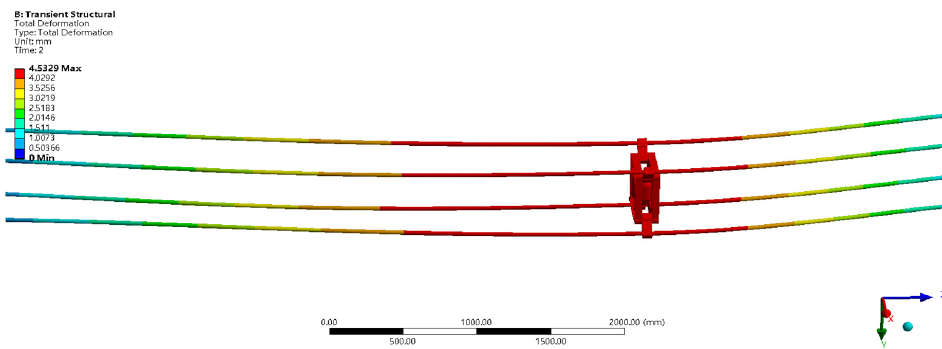
Figure 5. A cloud map showing the improved spacer bar’s galloping displacement.